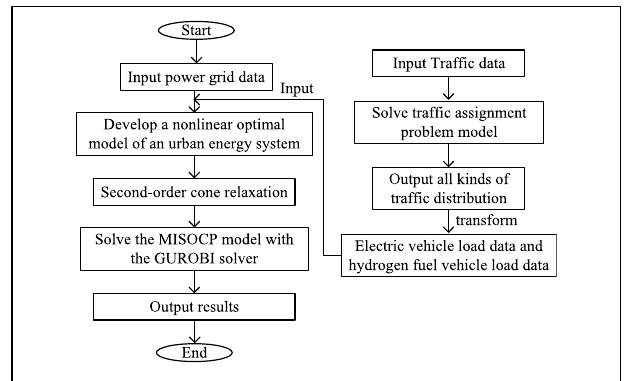
FIGURE 4 | Framework of the optimization dispatch